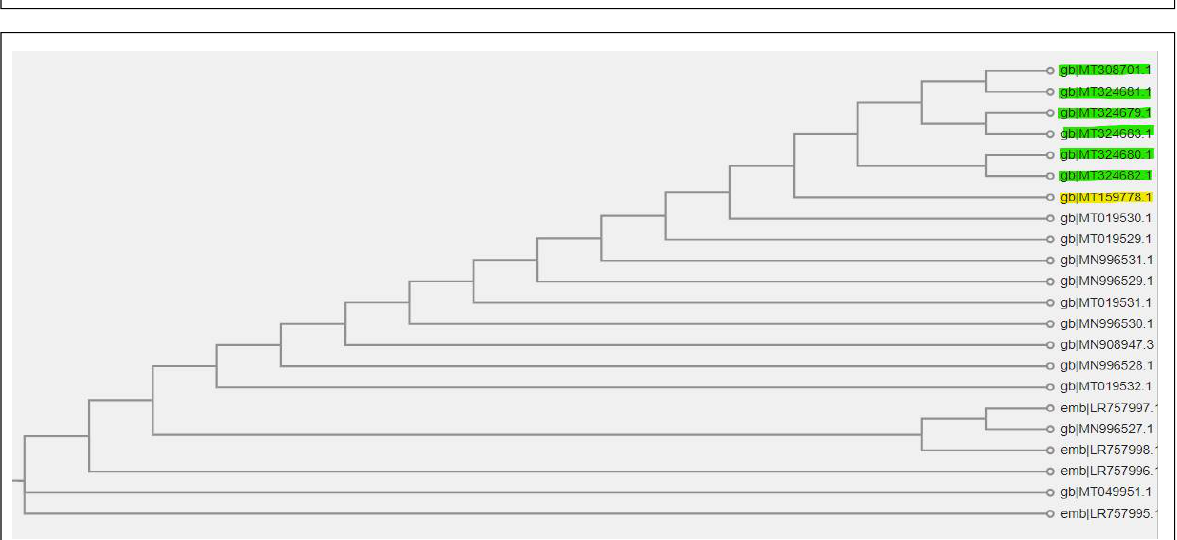
Figure 2: Neighbor Joining tree using 100 replicates (bootstraps) on number of nucleotide sequences from Covid- 19 strains from Spain (in red) and the earliest strains from China in the genbank (highlighted in yellow)